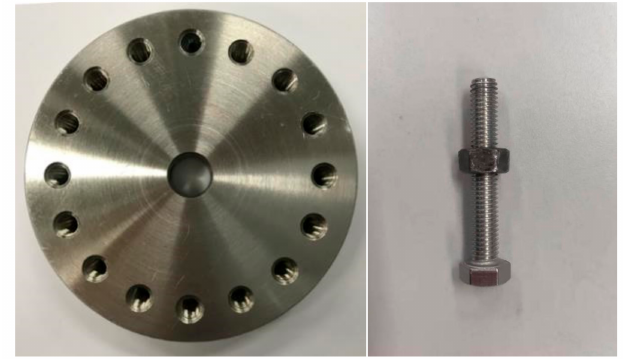
Figure 12. Disk and